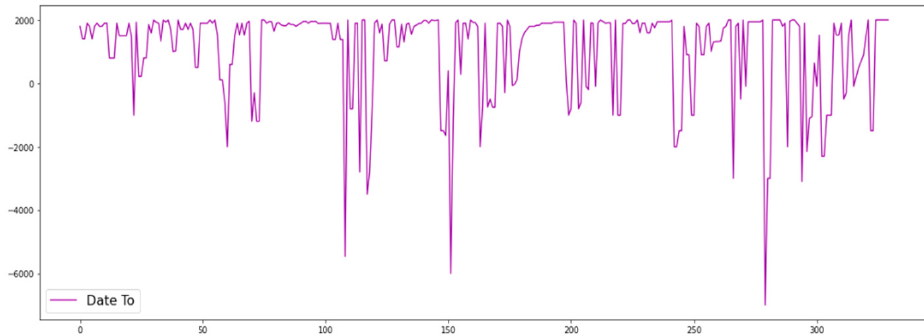
Figure 5. Shows the soil moisture of the Godavari Plateau Region.